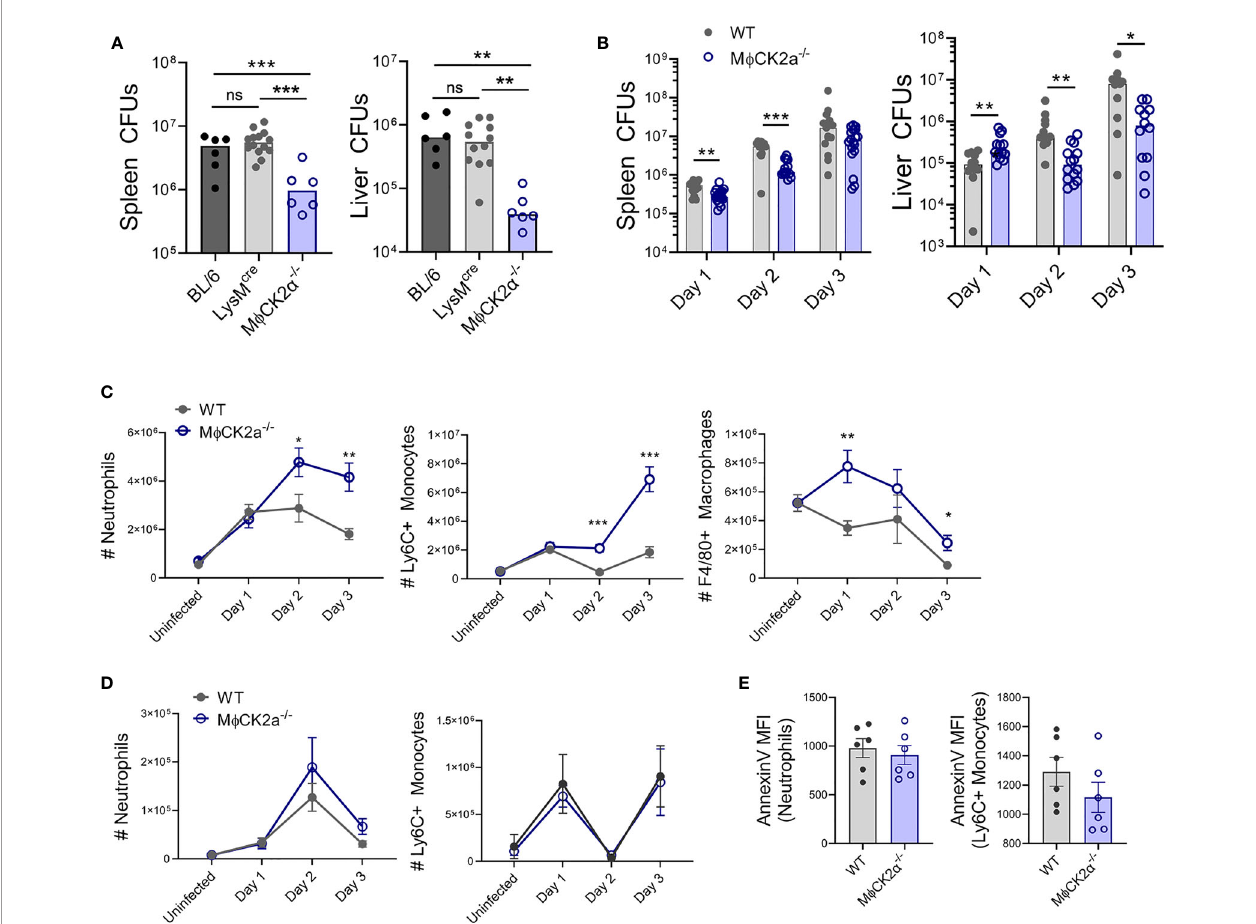
FIGURE 2 | Resistance to systemic Lm infection is improved in M f CK2 a − / − mice, which correlates with increased accumulation of in fl ammatory cells. (A) Lm burdens from infected C57BL/6 (B6), LysM cre , or M f CK2 a − / − mice. Colony forming units (CFU) per tissue were determined by dilution plating of tissue lysates at 2 days post-infection (dpi) with 10e+4 Lm. Symbols represent individual mice and bars indicate mean values. Data are pooled from two experiments and with n = 6 – 12 mice/group. (B) CFUs from BL/6 (WT) and M f CK2 a − / − mice at indicated dpi. Data pooled from three experiments, n = 9 – 12 mice/group. Cells were harvested from collagenase-digested (C) spleens and (D) livers of uninfected WT or M f CK2 a − / − mice or at the indicated day after Lm-infection. Myeloid cells were analyzed by fl ow cytometry with gating as in Figure 1 . Mean ± SEM cell counts per organ are shown. Data are pooled from three experiments, n = 9 – 12 mice/group. (E) Splenocytes harvested 2 dpi from infected WT and M f CK2 a − / − mice were stained for surface Annexin V to assess apoptosis. Shown are staining intensity (geometric MFI) for Annexin V stains on gated neutrophils and monocytes. Data pooled from two experiments, n = 6 mice/group. *p < 0.05, **p < 0.01, ***p < 0.001 and ns = p < 0.05 as measured by Student